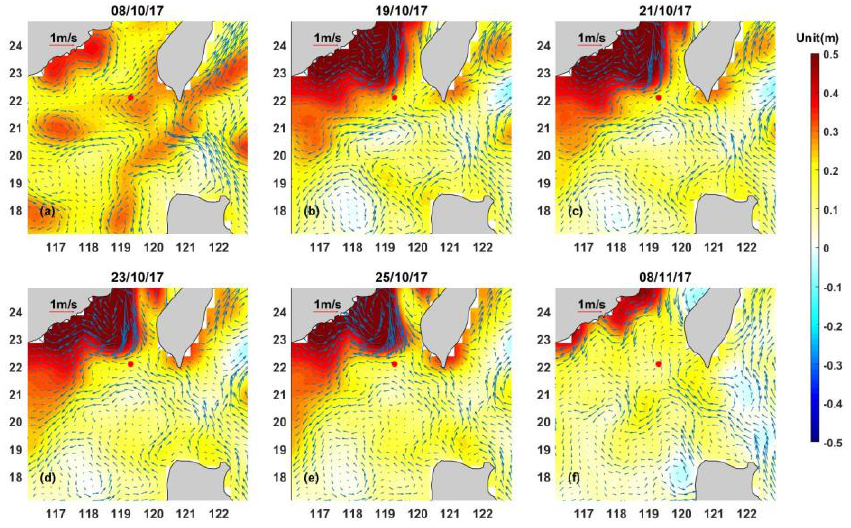
Figure 10. Sea level anomaly (SLA) on 8th October ( a ), 19th ( b ), 21st ( c ), 23rd ( d ), 25th ( e ) and 8th November ( f ). The unit of the color bar is meters. The standard flow velocity of one meter per second is shown on the upper right of each graph. The red dot marks the location of Lander.